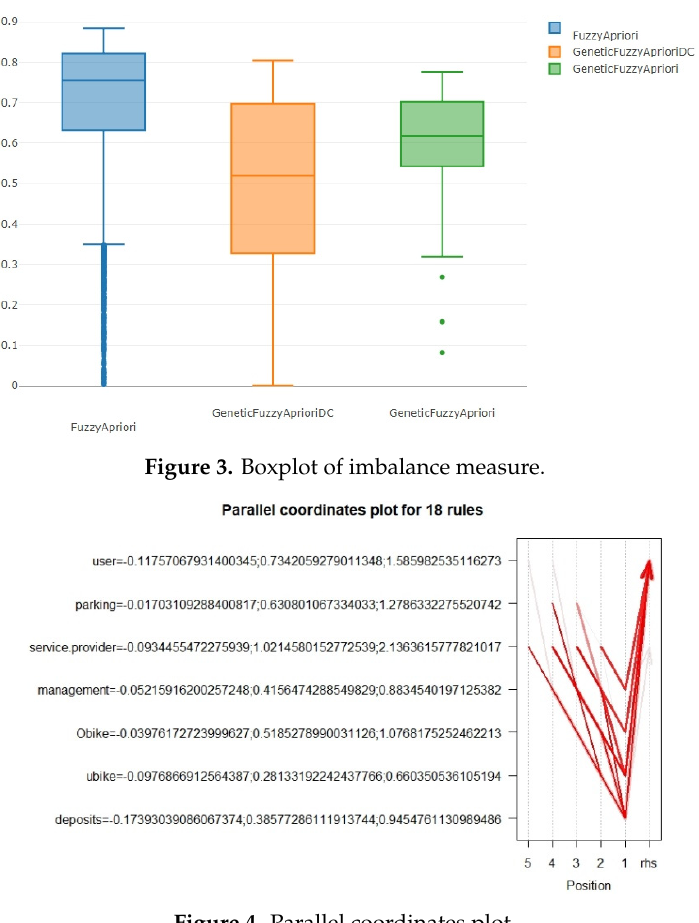
Figure 4. Parallel coordinates plot.